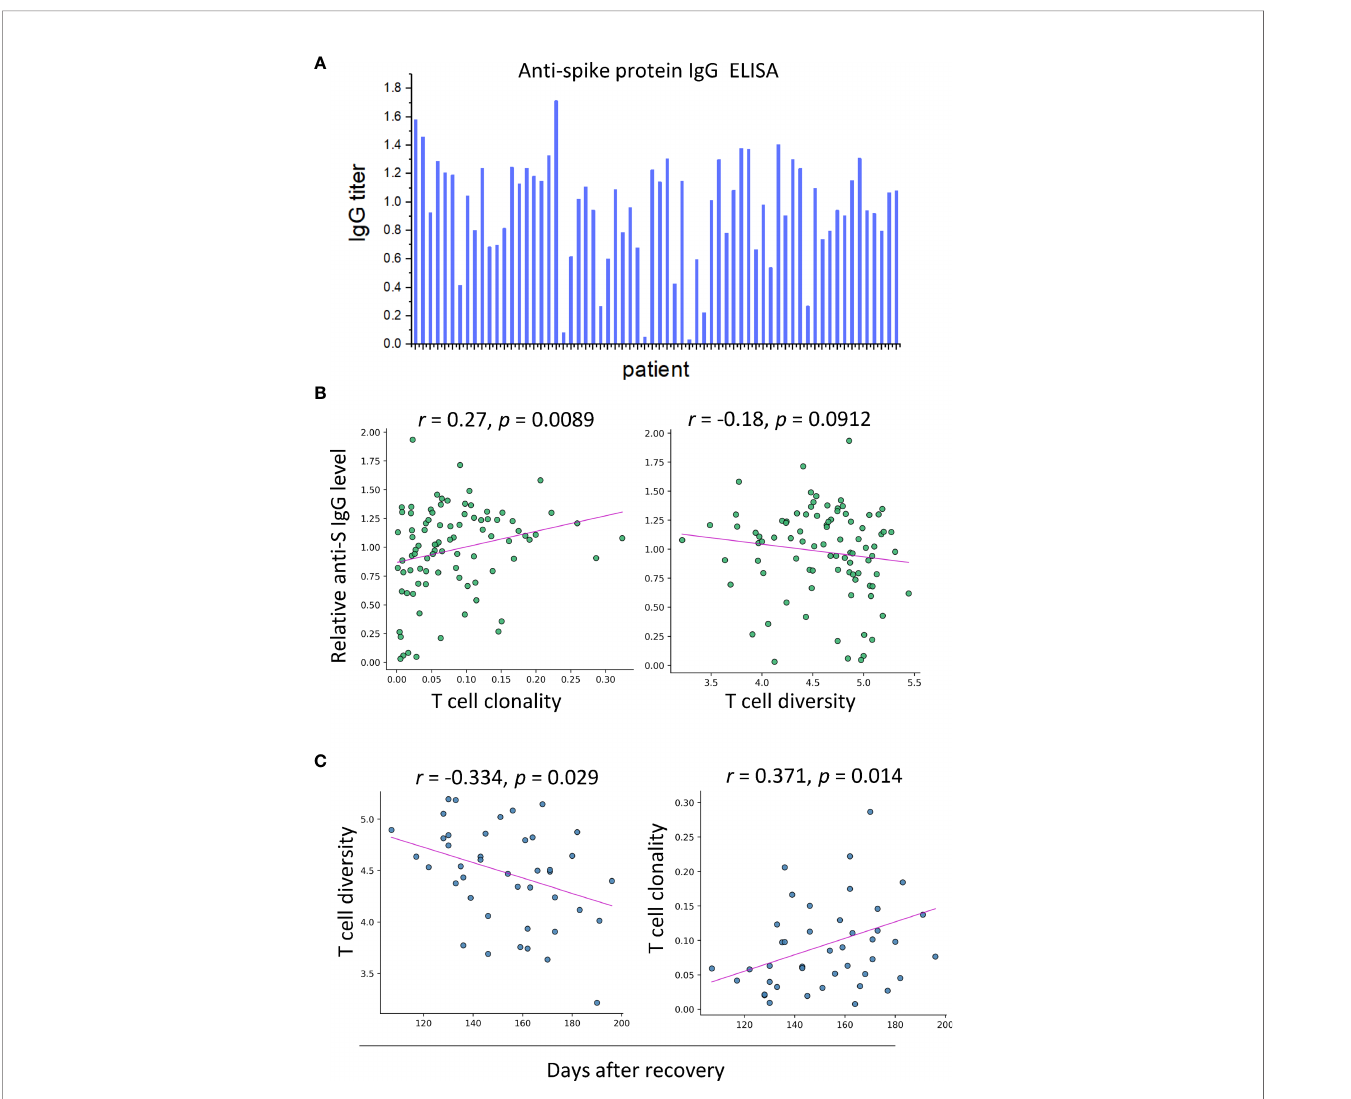
FIGURE 4 | SARS-CoV-2-speci fi c IgG is correlated with T-cell clonality in serum samples of convalescent patients ( n = 62). (A) The results of ELISA assays. (B) Correlation between anti-S IgG level and T-cell clonality and T-cell diversity, respectively. (C) T-cell diversity of blood samples of convalescents is negatively correlated with days after recovery, and T-cell clonality exhibits an increasing trend against days after